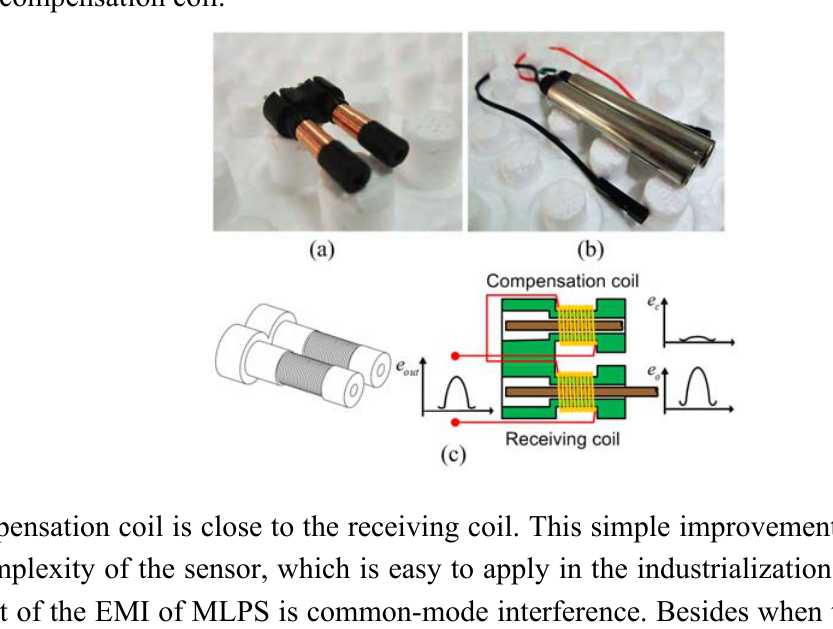
Figure 2. Structure of compensation coil ( a ) Receiving coil with compensation coil; ( b ) Coils installed with screening sleevings and connecting wires; ( c ) Schematic diagram of the compensation